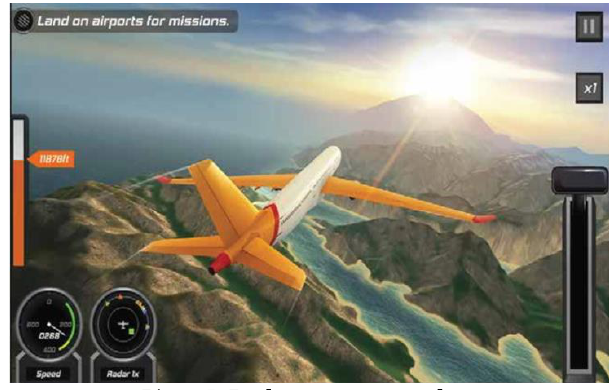
Figure 5: Explorers game example.